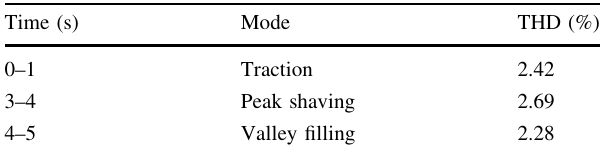
Table 3 THD of the